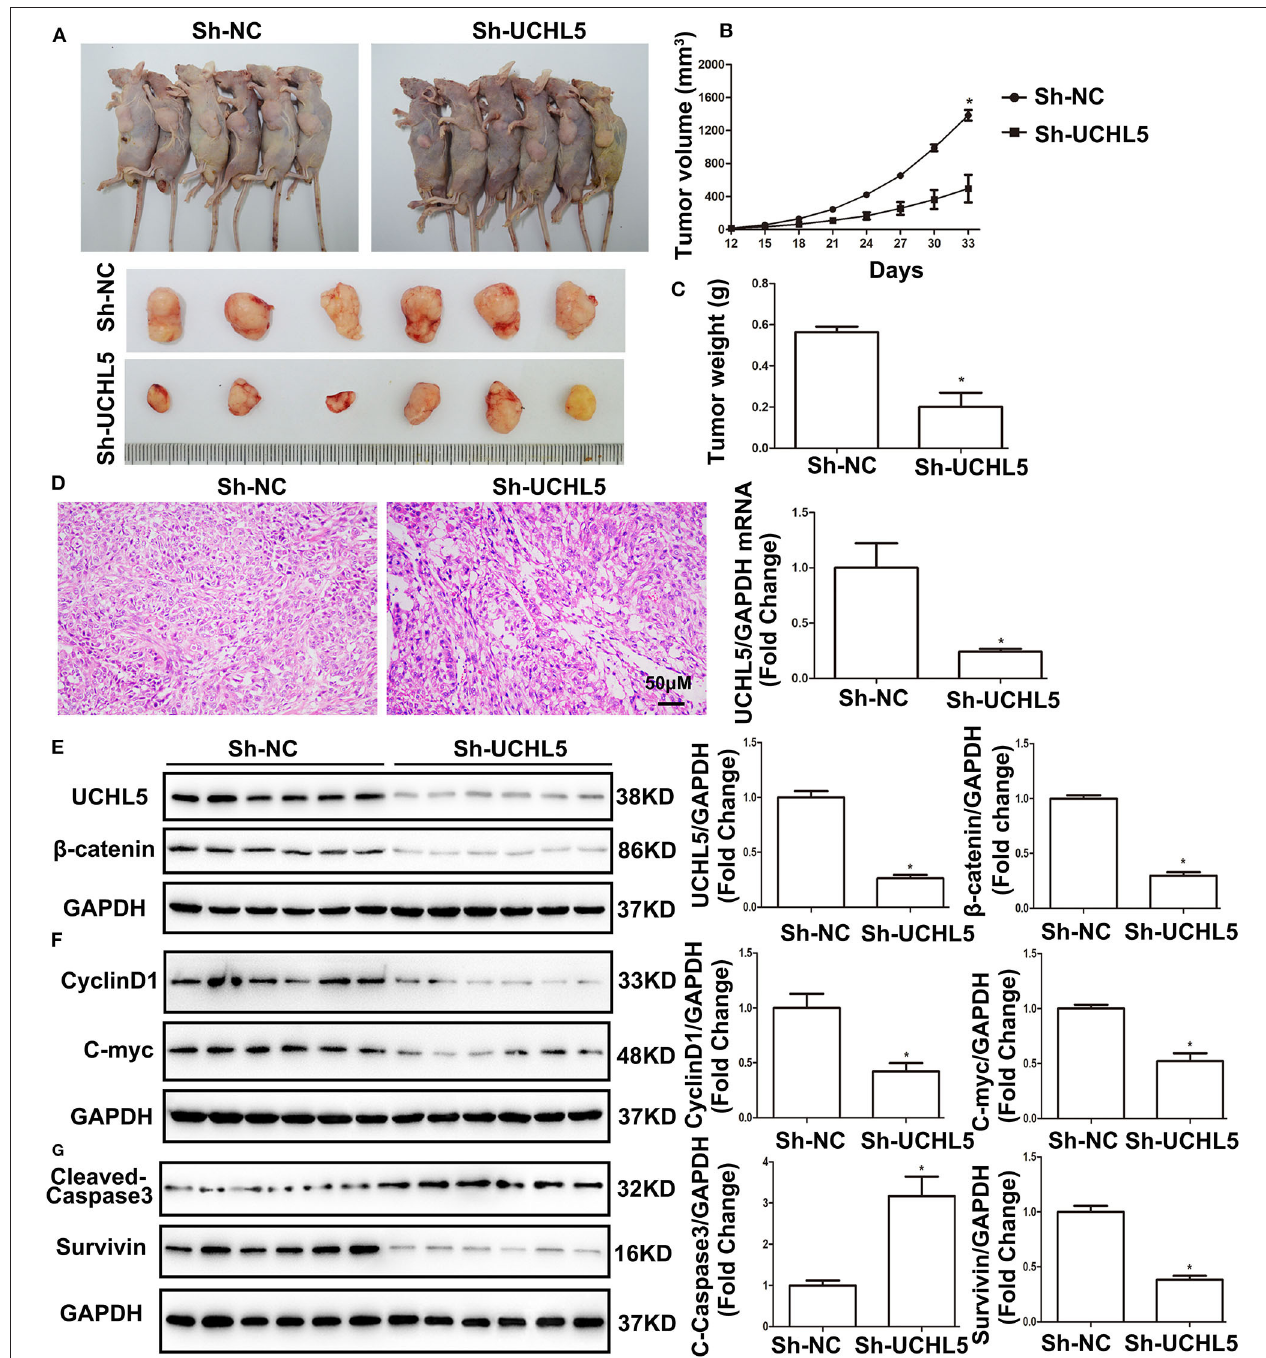
FIGURE 7 | UCHL5 silence restricted tumor growth via inhibiting Wnt/ β -catenin signaling pathway in vivo . (A) Images of HCE-1-A tumor-bearing nude mice and isolated primary xenograft tumors ( n = 6). (B) The growth curves of HCE-1-A primary xenograft tumors ( n = 6). * P < 0.05 vs. sh-NC. (C) The weight of xenograft tumors ( n = 6). * P < 0.05 vs. sh-NC. (D) Hematoxylin and eosin (HE) staining of tumors ( n = 6). (E) Western blot detected the expression of UCHL5 and β -catenin ( N = 3 times). * P < 0.05 vs. sh-NC. (F,G) Representative bands of CyclinD1, C-myc, cleaved-caspase3, Survivin, and GAPDH and their cartogram evaluated by western blot ( N = 3 times). * P < 0.05 vs.